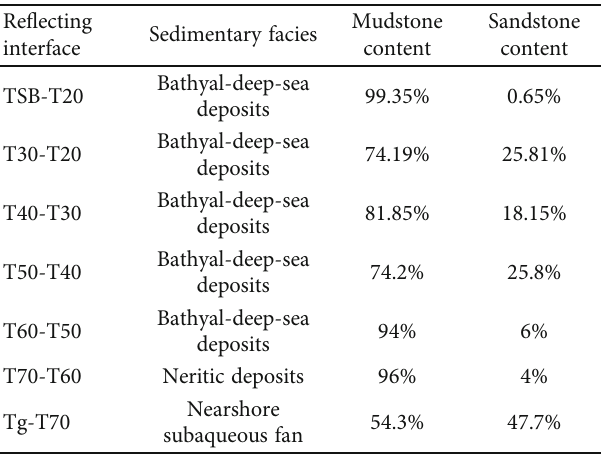
Table 1: Lithologic data for sequences of line 1 in the study area [50].